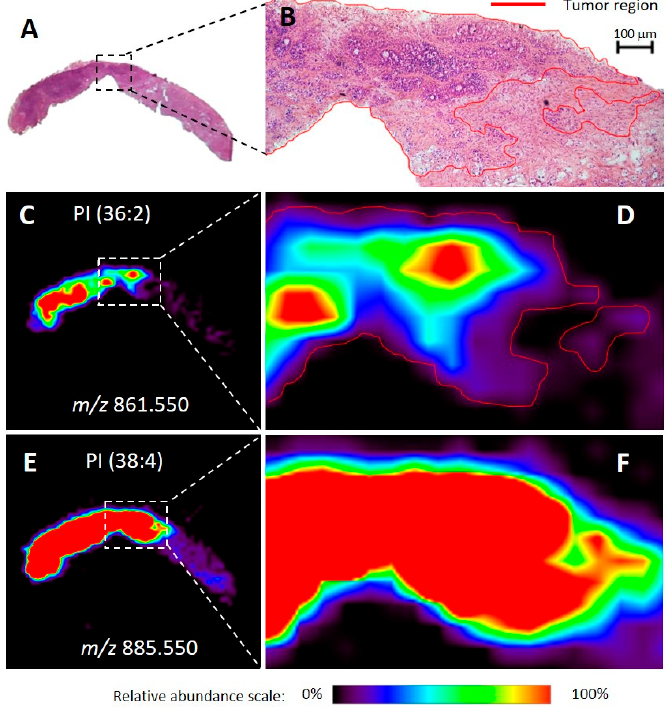
Figure 1. Optical images of hematoxylin & eosin (H&E) stained slides and representative ion images for a biopsied tissue sample diagnosed as invasive apocrine carcinoma of the breast with a signet ring. The entire tissue section is shown in ( A ) and the optical magnification (40 × ) of a region is shown in ( B ), with red-marked tumor areas. The representation of the relative abundance of a tumor discriminatory ion of mass-to-charge ratio ( m / z ) 861.550 is shown in ( C ). Zoomed in and outlined in red, ( D ) shows a comparative perspective with the H&E image above ( B ). The representation of the relative abundance of a non-discriminatory ion of m / z 885.550 is shown in ( E ). Also, zoomed-in, ( F ) shows a comparative perspective with images D and B above. Areas of red intensity within the ion images represent the highest (100%) and black the lowest (0%) relative abundance. PI: glycerophosphoinositol. Lipid species are described by the numbers of fatty acid chain carbons and double